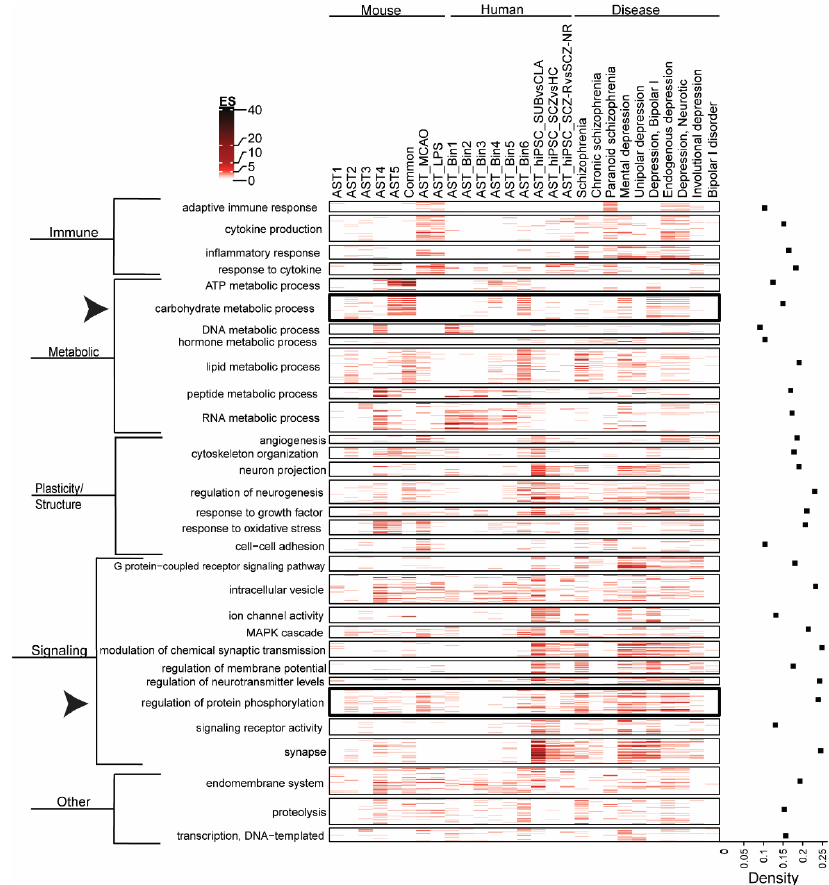
Figure 2. Enrichment of clustered biological pathways across astrocyte gene-sets and neuropsychiatric and neurological disorders. Color intensity is proportional to -log10 ( p -value). Density index for all pathway clusters across astrocyte groups and disorders is displayed to right of heatmap. Arrowhead highlights pathways “regulation of protein phosphorylation” and “carbohydrate metabolism”. AST astrocyte, CLA astrocyte classical subtype, ES enrichment score, HC healthy control, hiPSC human induced pluripotent stem cell, LPS lipopolysaccharide, MCAO middle cerebral arterial occlusion. SCZ schizophrenia, SCZ_R clozapine responder, SCZ_NR clozapine non-responder, SUB astrocyte